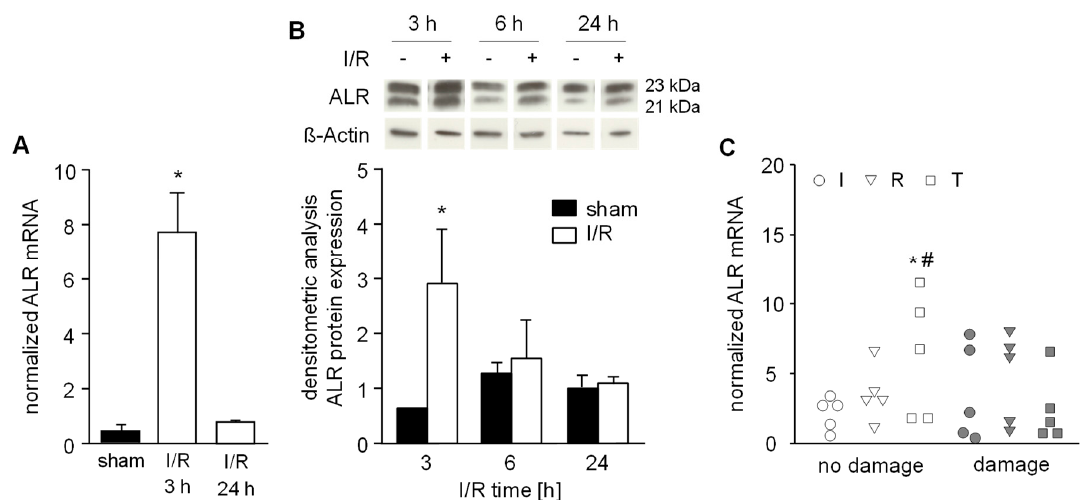
Figure 5. Hepatic ALR expression after ischemic reperfusion. A) Mice were subjected to ischemia as described in Material and Methods and liver tissue samples were taken after 3 h or 24 h ( n = 6 each) of reperfusion. ( A ) ALR mRNA and ( B ) ALR protein expression in liver tissue samples were analyzed by qRT-PCR and western blotting, respectively. Expression of ALR mRNA was normalized to 18S, ALR protein to ß-actin and sham operated animals ( n = 3) served as control. * p < 0.05 differs from sham. Immunoblots from 3 different experiments were analyzed by densitometric analysis and one representative blot is shown (for all data see Figure S4). C ) Human liver biopsies were obtained from livers prior to transplantation (I: after ischemia, pre-reperfusion, n = 10), immediately before abdominal closure (R: approximately 0.5 h post-reperfusion, n = 10) and during a 2nd look operation (T: 24h-48h after reperfusion, n = 10). Liver biopsy samples were examined by a pathologist evaluating HE histochemistry and assigned according to “no damage” (<5% necrosis) or observed tissue “damage” (>5% necrosis). Expression of ALR mRNA was normalized to YWHAZ with * p < 0.05 or # p < 0.05 differs from ischemia with no damage or reperfusion with damage, respectively.